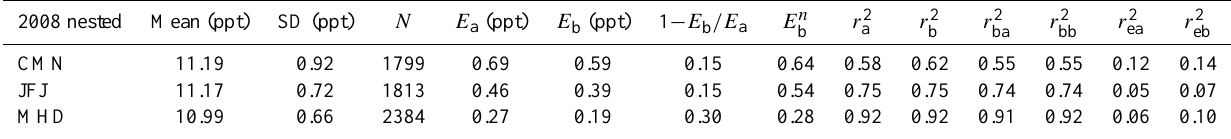
Table A2. Single station parameters. Mean; SD, standard deviation; N , number of observation; E a , rms error priori; E b , rms error posteriori; 1 − E a /E b , relative error reduction; E n , a posteriori error normalised with the standard deviation of the observed concentration minus base- b line; r 2 a , squared Pearson correlation coefficients between the observations and the total a priori; r 2 , squared Pearson correlation coefficients b between the observations and the total a posteriori; r 2 , squared Pearson correlation coefficients between the observations and the a priori ba baseline; r 2 , squared Pearson correlation coefficients between the observations and the a posteriori baseline; r 2 ea , squared Pearson correla- bb tion coefficients between the observation minus the a priori baseline and the modelled a priori; r 2 , squared Pearson correlation coefficients eb between the observation minus the a posteriori baseline and the modelled a